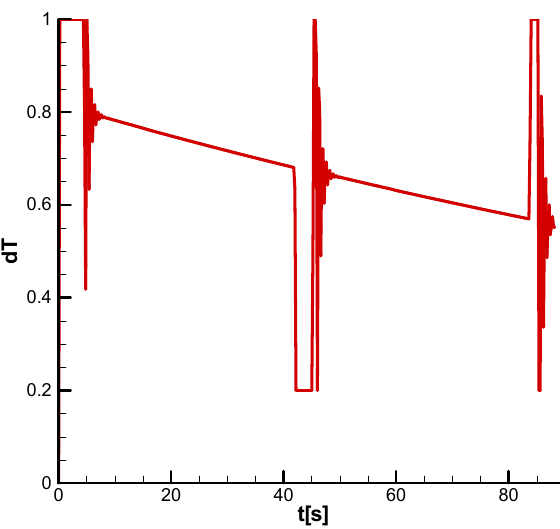
Figure 14. Diagram of the thrust throttling command dT .